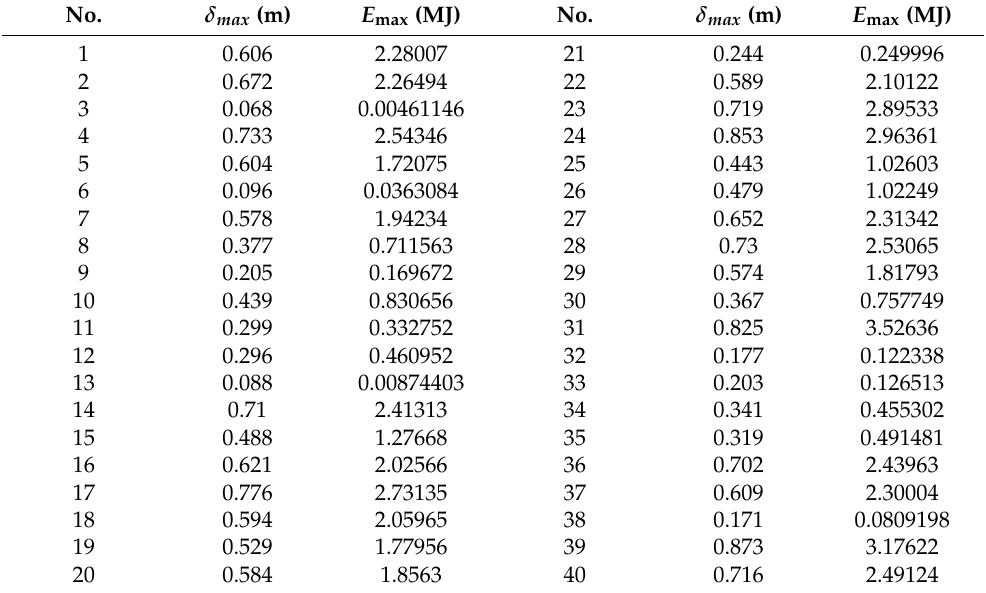
Table 4. Collision response results of training samples obtained via FEA.